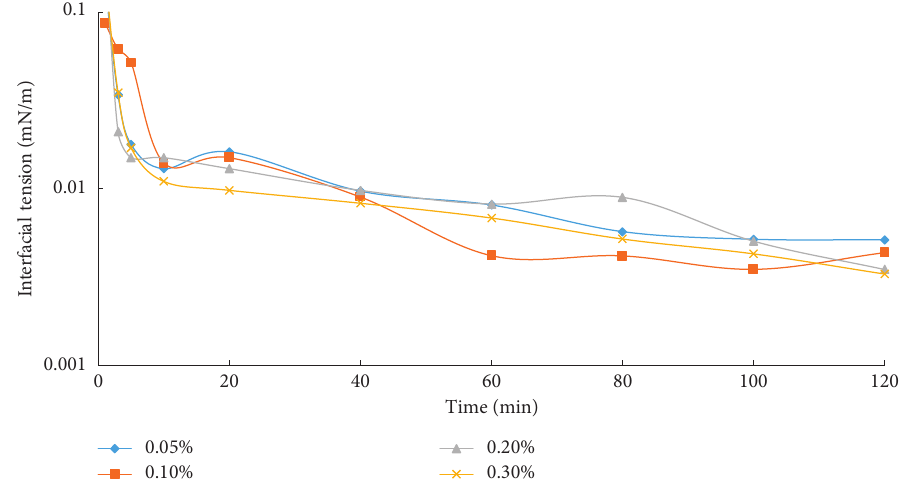
Figure 5: Dynamic interfacial tension of the synthesized surfactant at different concentrations.